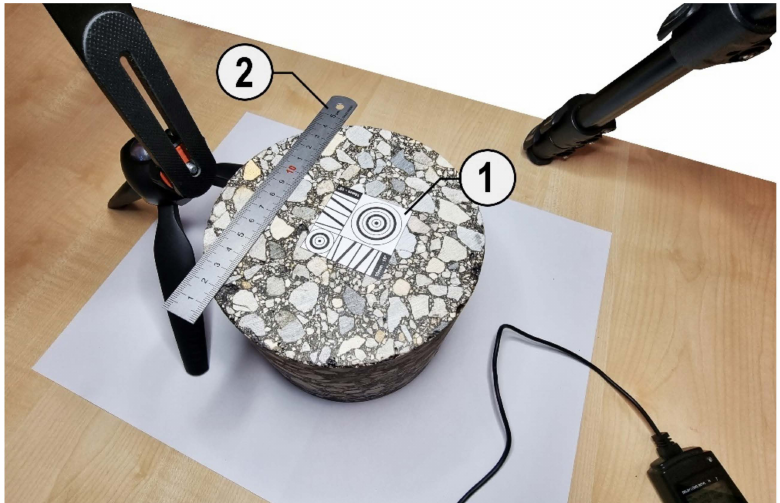
Figure 3. Specimen surface with the calibration pattern (1) and ruler as a length standard